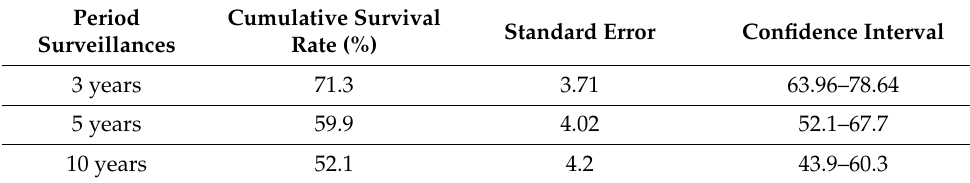
Table 2. Cumulative proportional survival of patients.